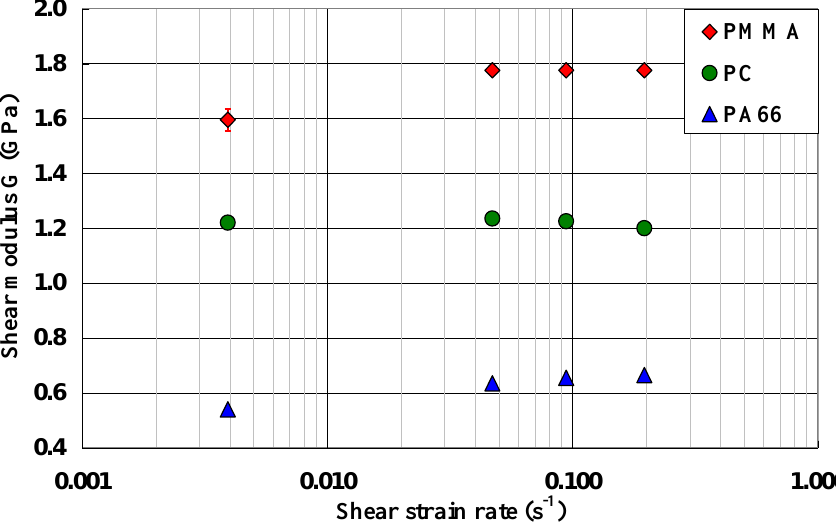
Figure 8. Shear moduli versus the equivalent strain